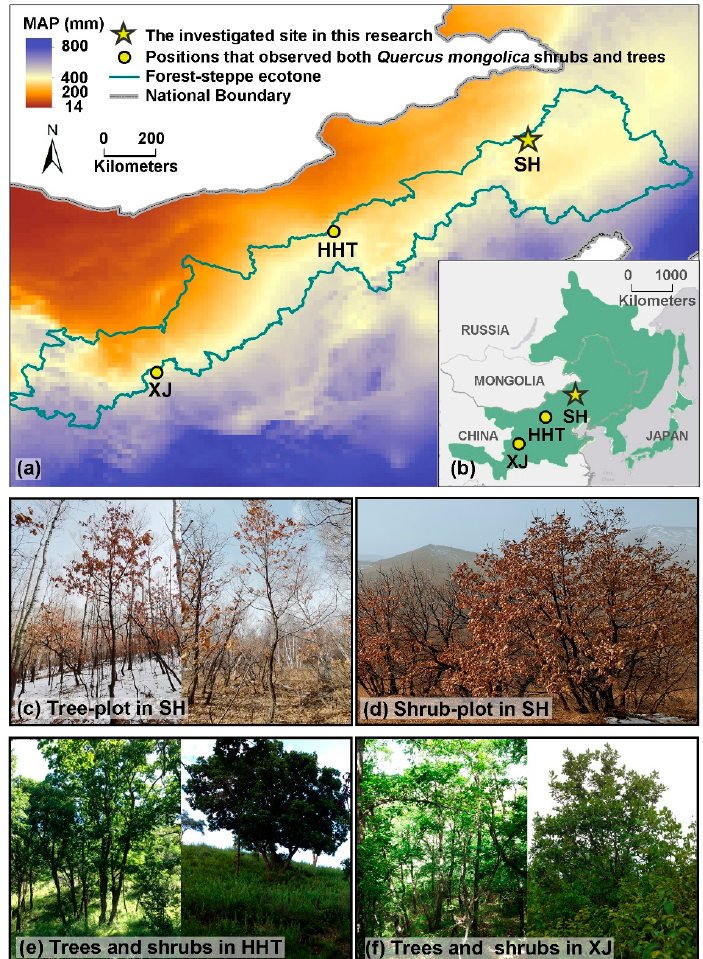
Figure 1. ( a ) The location of the investigated site and mean annual precipitation (MAP) pattern in the semiarid region. ( b ) The green area shows the natural distribution of Quercus mongolica globally [15]. Yellow stars in Panels ( a , b ) show the locations where the investigated Q. mongolica tree and shrub plots are located in the SH region. Yellow circles show the places where similar abrupt tree-to-shrub shifts were discovered during previous investigation. ( c , d ) Quercus mongolica trees on shady slopes and shrubs on sunny slopes in the SH region. Photos were taken by J. Dai in March 2021. ( e , f ) Quercus mongolica trees and shrubs in HHT and XJ, respectively. Photos were taken by J. Dai in July 2016.